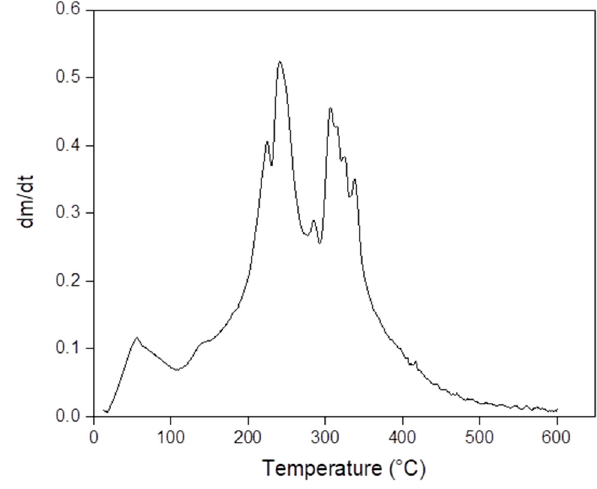
Figure 3. DTG analysis of sample S6.